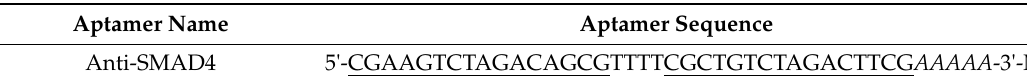
Table 1. Sequence of DNA-aptamer to rSMAD4 protein. The complementary parts of the sequence are underlined. The regions responsible for binding to SMAD4 (SMAD-binding element, SBE) and poly(dA) 5 linker are shown in bold and italic, respectively; ‘M’ stands for biotin or FAM (6-carboxyfluorescein) attached to the